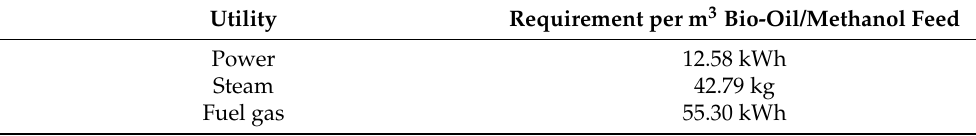
Table 2. Utilities consumption for